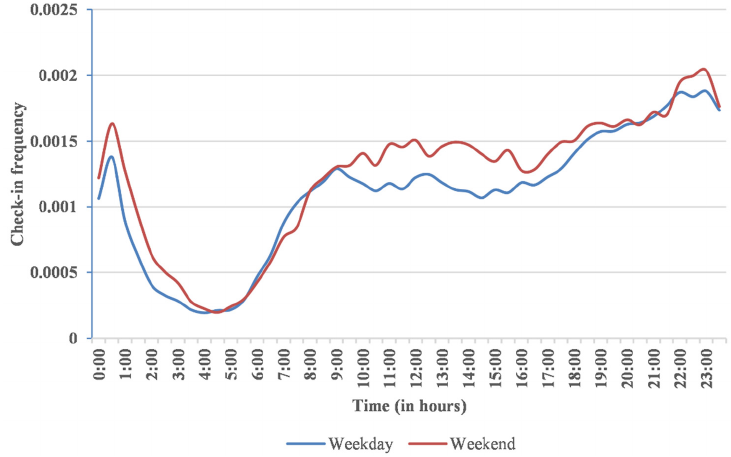
Figure 11. Check ‐ in frequency of males during weekdays and the weekend. Figure 11. Check-in frequency of males during weekdays and the weekend.